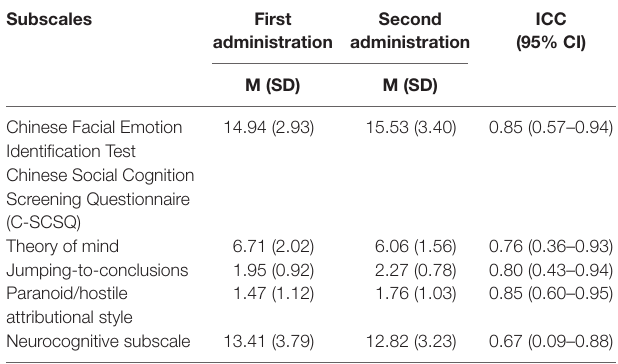
TaBle 3 | Relationship between social cognitive performance (C-FEIT and C-SCSQ) and demographic characteristics, neurocognition, and clinical symptoms.